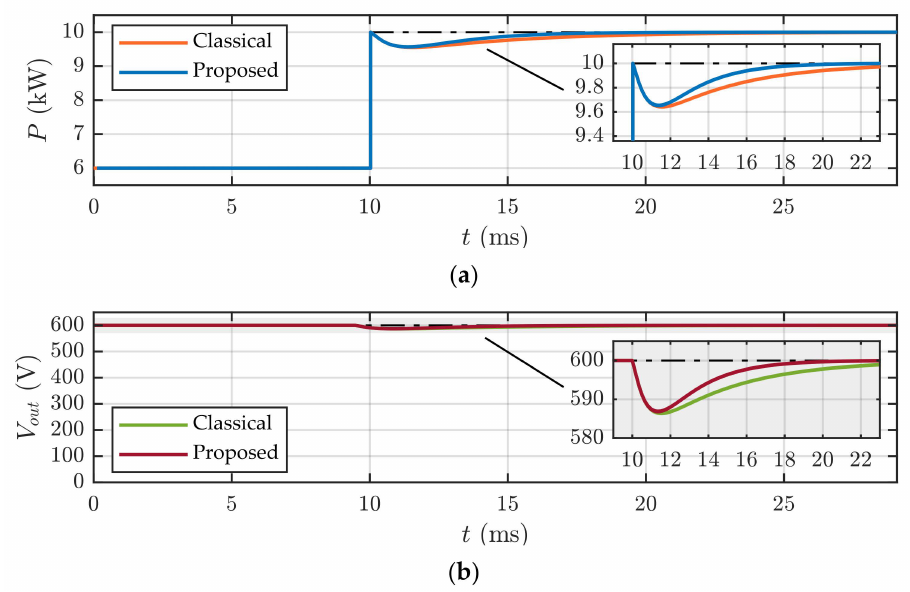
Figure 15. Output power ( a ) and output voltage ( b ) change on the DC bus when load changes from 6 kW to 10 kW of both classical pole-placement and proposed control